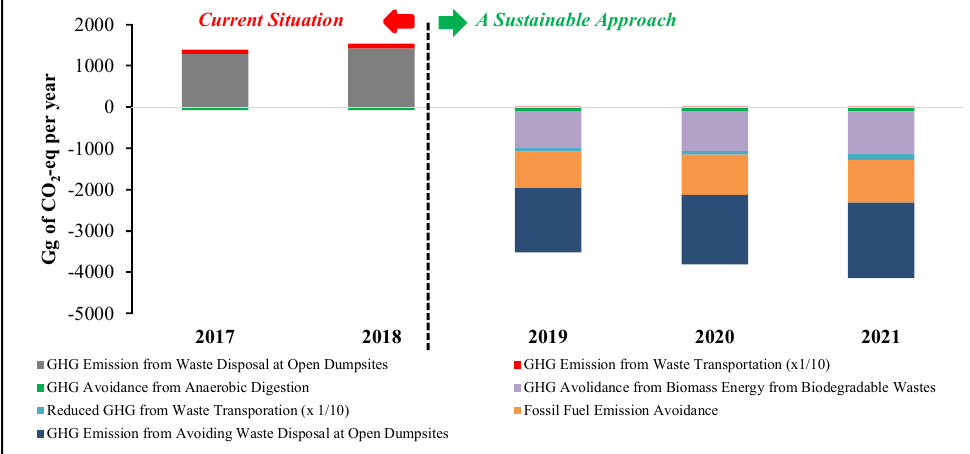
Figure 10. Comparison of GHG emission/avoidance from the waste disposal of biodegradable waste between the current situation and a sustainable approach to waste management in Myanmar.